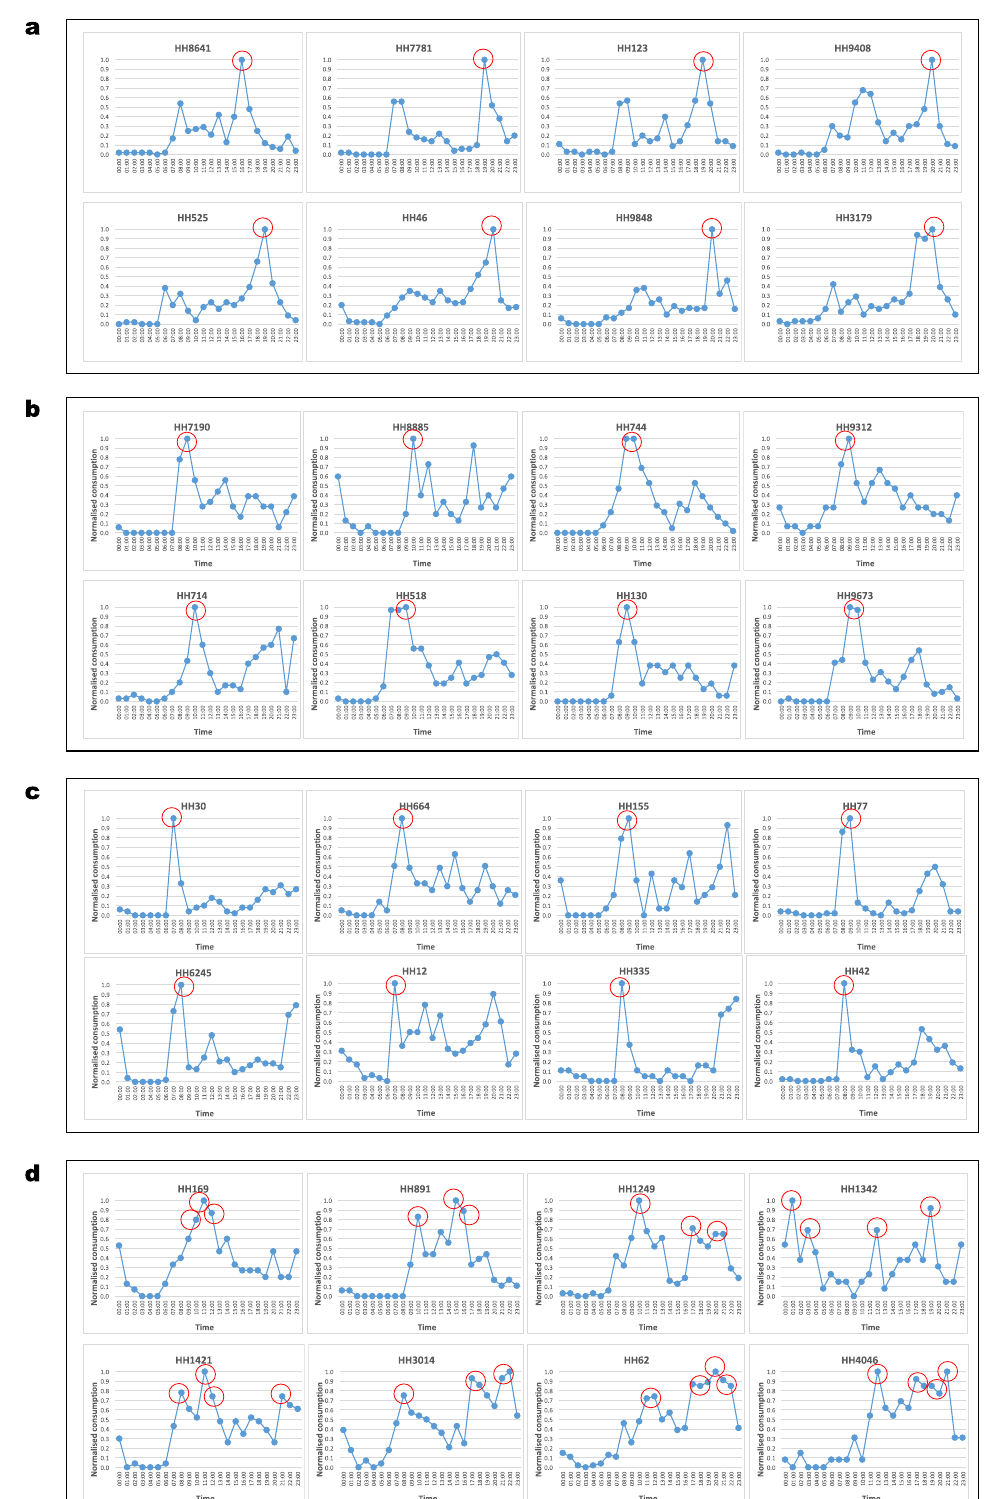
Fig. 3 24 h patterns of individual households in clusters. a 24-hour patterns for a random sample of households in the EP cluster. a 24-hour patterns for a random sample of households in the LM cluster. a 24-hour patterns for a random sample of households in the EM cluster. a 24-hour patterns for a random sample of households in the MP cluster. a – d Circles indicate observed